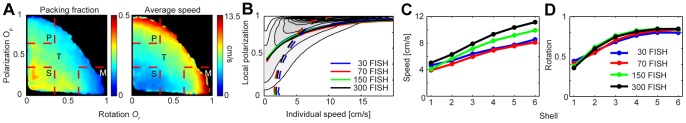
Structural properties.(A) Density plots of packing fraction and average individual speed (averaged per frame) as functions of rotation Op and polarization Or for 150 fish. (B) The plot illustrates the correlation between individual speed and local polarization estimated in two ways from the underlying density maps (the example shown in the background is for 150 fish). The stapled curves are produced by averaging across individual speeds for each value of the order parameter; the solid curves from averaging across the order parameter values for each individual speed. The local polarization of an individual fish is defined as the polarization Op restricted to the area inside a circle with radius 15.6 cm (approximately 3 body lengths) centered at the individual fish. (C) Average individual speed at different radial positions in the milling state. (D) Average rotational order parameter at the same positions. The radial division of the milling state in (C) and (D) is constructed by centering six shells outside each other, where the outermost shell has a radius defined by the distance from the group's center of mass to the median distance of the five most peripheral fish (see illustration in Fig. S11). The width of each shell is the radius of the outer shell divided by six. The averages are calculated for each shell, where the outer shell even includes peripheral fish.